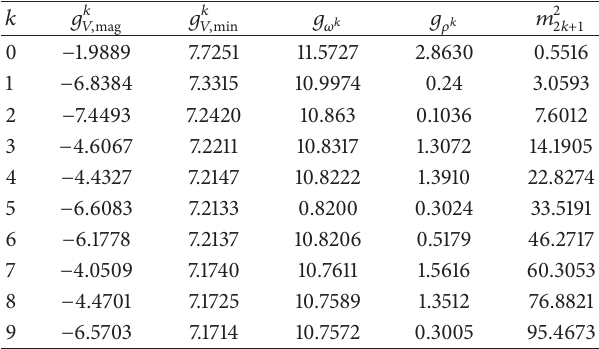
Table5:Numericalresultsofvectormesoncouplingstothenucleon for the ten lowest mesons using the AdS 6 model. Meson masses are unit. in the 𝑀 KK